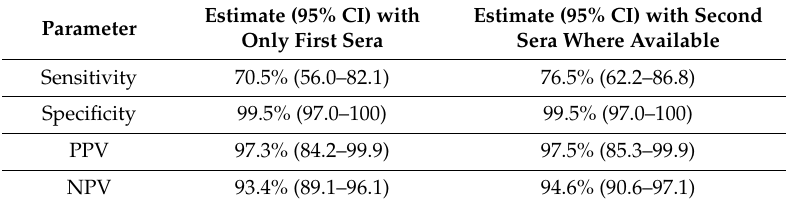
Table 3. Estimated clinical parameters for detecting antibodies in TBRF IBs.